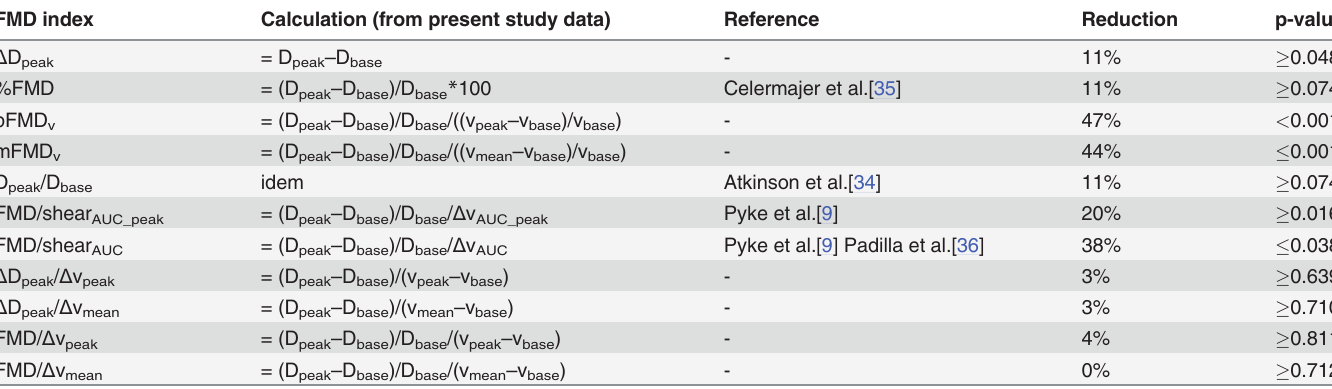
Table 2. Tracking performance of FMD v compared to existing FMD indices.